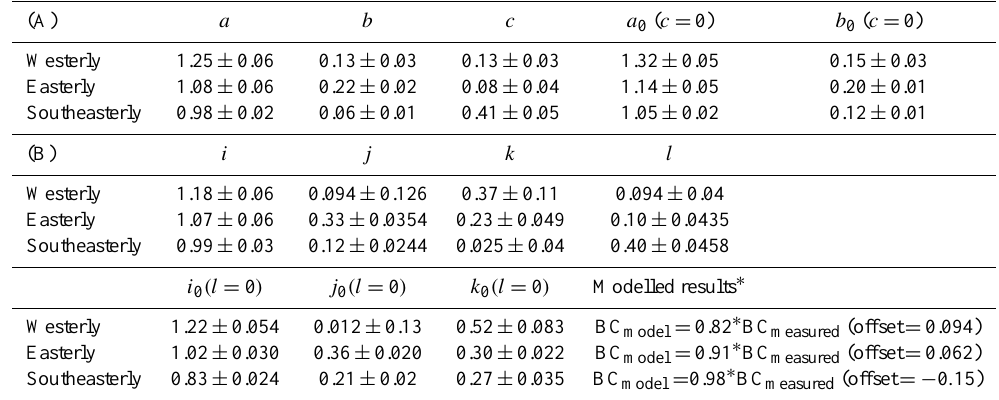
Figure 3. (a) Time series of AMS-PMF mass loading results for HOA, SFOA I and SFOA II; (b) Modelled BC mass by tri-linear regression compared with the measurements for different air masses (note the bi-linear regression is also tested but not shown in this figure); (c) BC–AMS–PMF attributed BC sf mass fraction by tri-linear regression. Table 2. (A) The bi-linear regression results for the BC–AMS–PMF attribution. (B) The tri-linear regression results for the BC–AMS–PMF attribution. ∗ Denotes an orthogonal distance regression